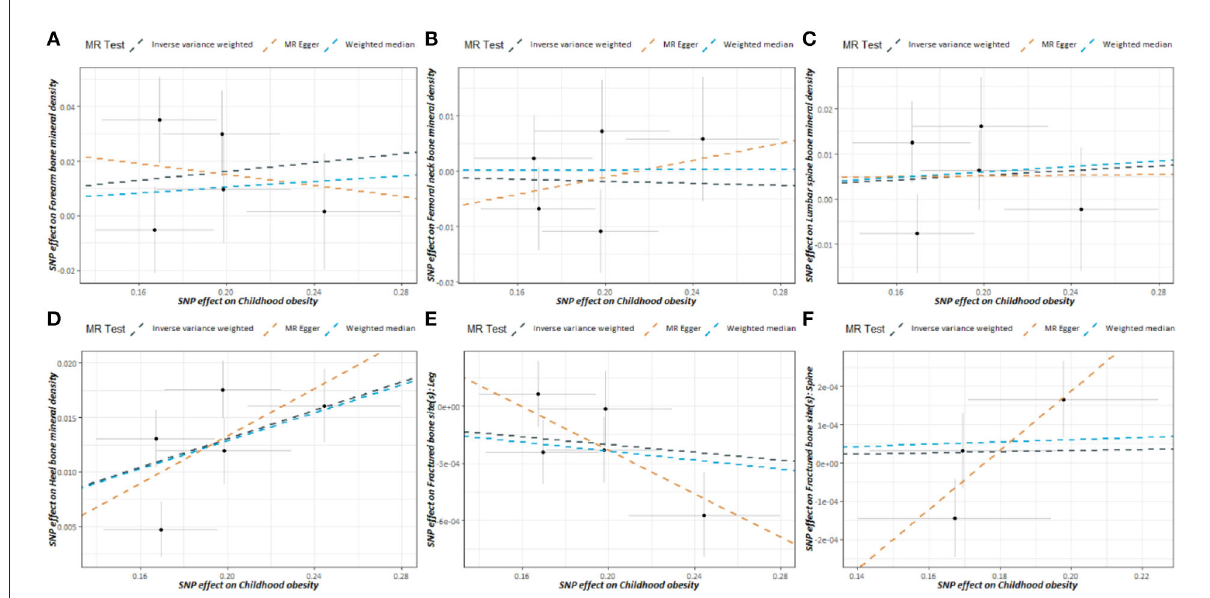
FIGURE2 Scatter plot of childhood obesity-associated SNPs potential impacts on BMD and the risk of fracture in adulthood. (A) Forearm BMD, (B) Femoral Neck BMD, (C) Lumber Spine BMD, (D) eBMD, (E) leg fracture, (F) Spine fracture. The black dots represent the association of individual IV with childhood obesity and the association of individual IV with BMD, fracture. Vertical and horizontal lines denote the 95% CI of OR for each IV. The slope of each line denotes the estimated causality per MR method. BMD, Bone mineral density; IV, instrumental variable; MR, Mendelian